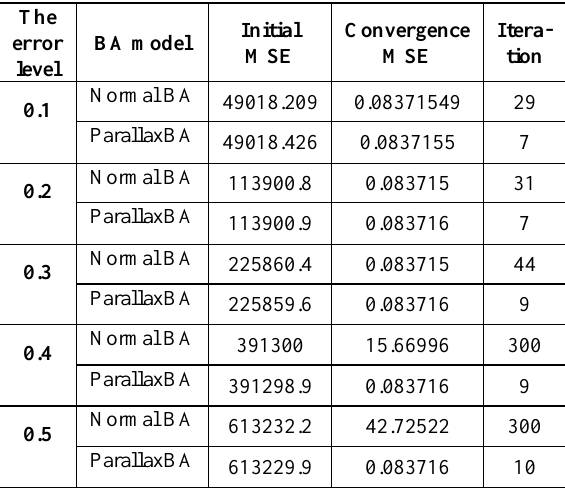
Table 3. The convergence of the ParallaxBA model and the normal BA model given different initial values of camera line elements